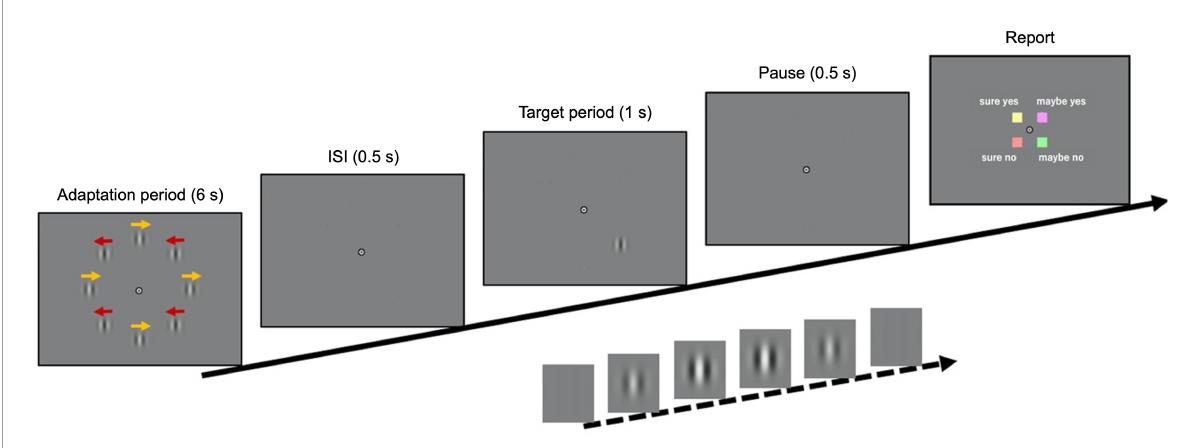
FIGURE1 Time course of visual stimuli. The adaptation stimulus, composed of eight drifting Gabor patches, was presented for 60 s (the first trial) or 6 s (all other trials). After an inter-stimulus interval of 0.5 s, a target stimulus was presented in 80% of the trials for 1 s (either at the top-left or bottom-right positions in 65% of the trials, and at the other positions in 15%). In the remaining 20% of the trials, the target was absent. When a target was presented, its contrast was filtered with a temporal Gaussian window to reach its maximum value 0.5 s after the onset. The maximum contrast in the main experiment was determined in a calibration experiment using a staircase method. Finally, after a pause of 0.5 s, the response key assignment was displayed until the participant